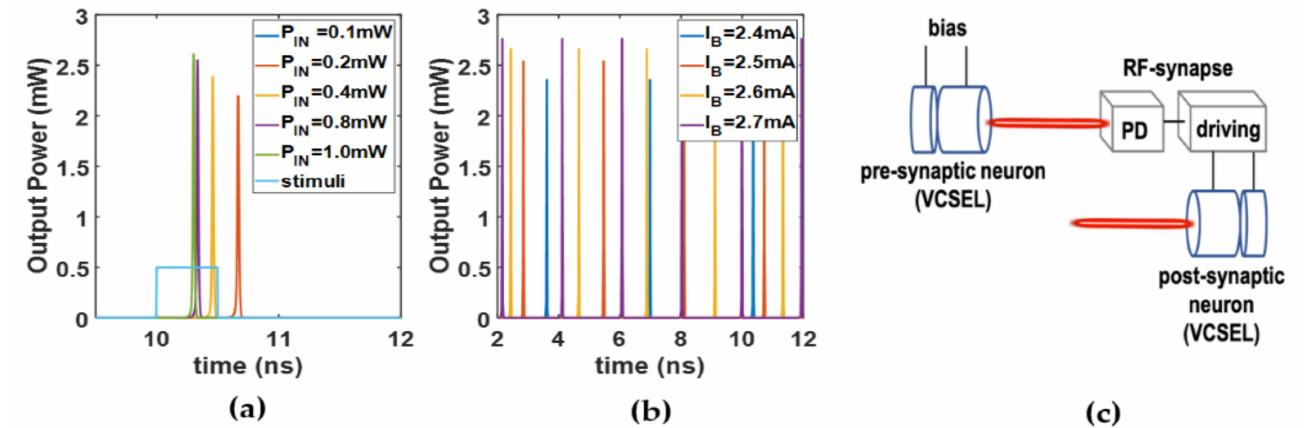
Figure 1. ( a ) VCSEL operation in excitable regime for different levels of input power. For P IN = 0.1 mW no spike is generated (under threshold stimuli) while for higher P IN values a spike is fired. Higher P IN decreases the latency and enables the timing encoding of the input’s power level. The bias current is I b = 2.32 mA while the duration of the applied stimuli is T ON = 0.5 ns. ( b ) VCSEL operation in spiking regime for different biases. Higher I b decreases the T sp (interspike interval). ( c ) Photonic VCSEL neurons and Radio Frequency (RF) synapse configuration, PD stands for